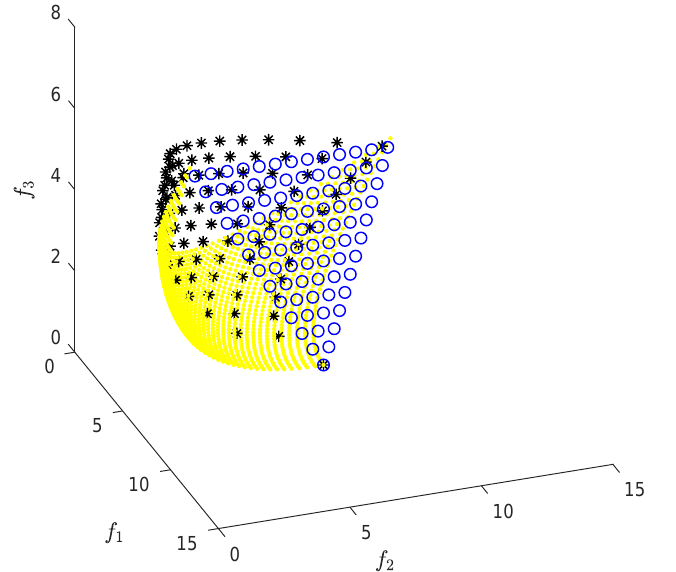
Figure 3. Example where the normal-boundary intersection (NBI)method is not able to get a good approximation to the entire Pareto